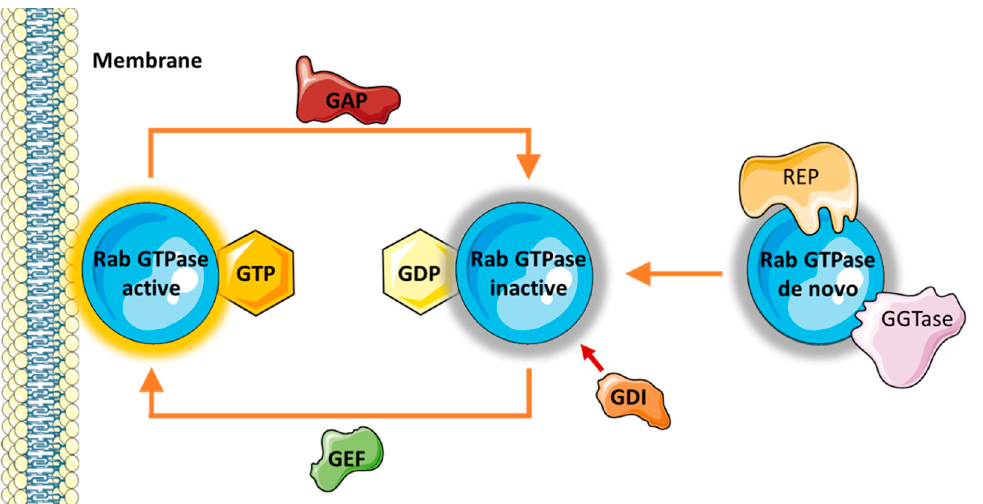
Figure 2. The cycle of Rab GTPase activation. Newly synthesised de novo Rab GTPases interact with Rab escort protein (REP), which enables prenylation via geranylgeranyltransferase (GGTase). When active, Rab GTPases are bound to GTP and associated with their target membrane. Following hydrolysis of GTP to GDP, they become inactive and reside in the cytosol. The Rab GTPase activation cycle is aided by a number of effectors. GTPase activating proteins (GAPs) catalyse the hydrolysis of GTP to GDP to inactivate the Rab. GDP dissociation inhibitors (GDIs) retrieve the inactive Rab from the membrane and solubilises it in the cytosol. However, guanine exchange factors (GEFs) catalyse the exchange of GDP with GTP, thus reactivating the Rab [12].